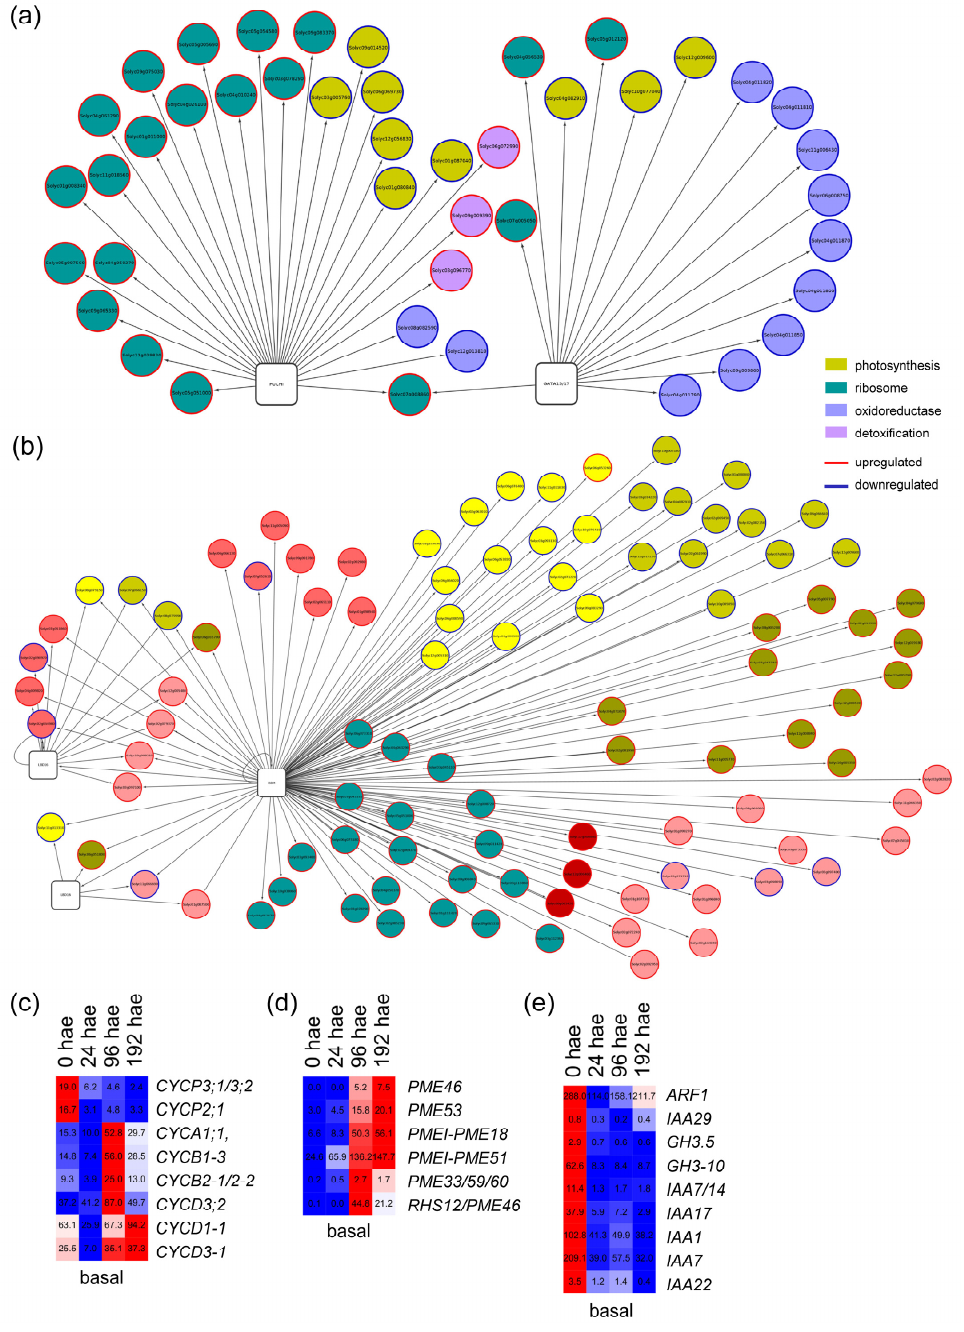
Figure 5. GRNs for putative TF genes and their deregulated targets associated with P11 and P15 profiles in the basal region of the hypocotyl. ( a , b ) Selected GRNs from P11 ( a ) and P15 ( b ) profiles. ( c – e ) Hierarchical clustering over time of selected putative targets from P11 ( c , d ) and P15 ( e ) profiles. Blue/white/red indicate in ( c – e ) normalized cpm values in each row, where red indicates the highest abundance of transcripts. Gene annotations are found in Tables S1 and